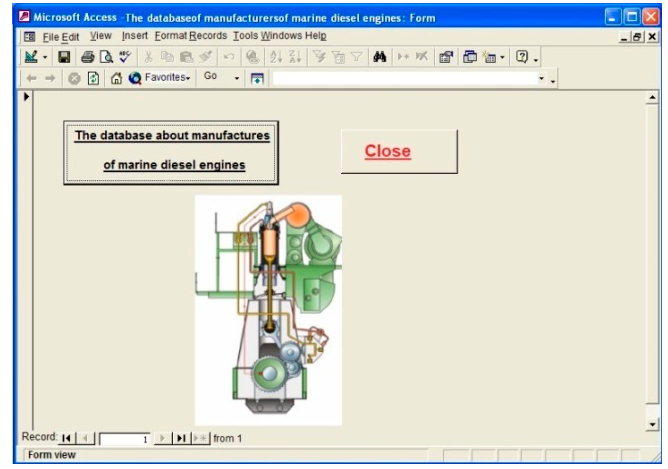
Figure 2. Graphic of the database start form.